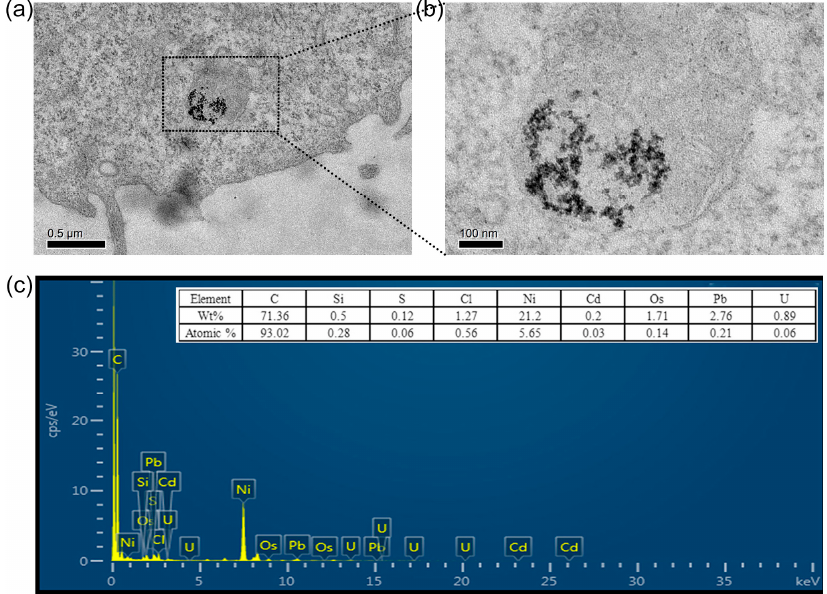
Figure 6. ( a ) TEM image of a HepG2 cell incubated with CdS QDs for 24 hours; ( b ) The enlarged TEM image of CdS QDs naturally created in the lysosome of the HepG2 cell; ( c ) The EDS spectrum of CdS QDs inside the HepG2 cell.